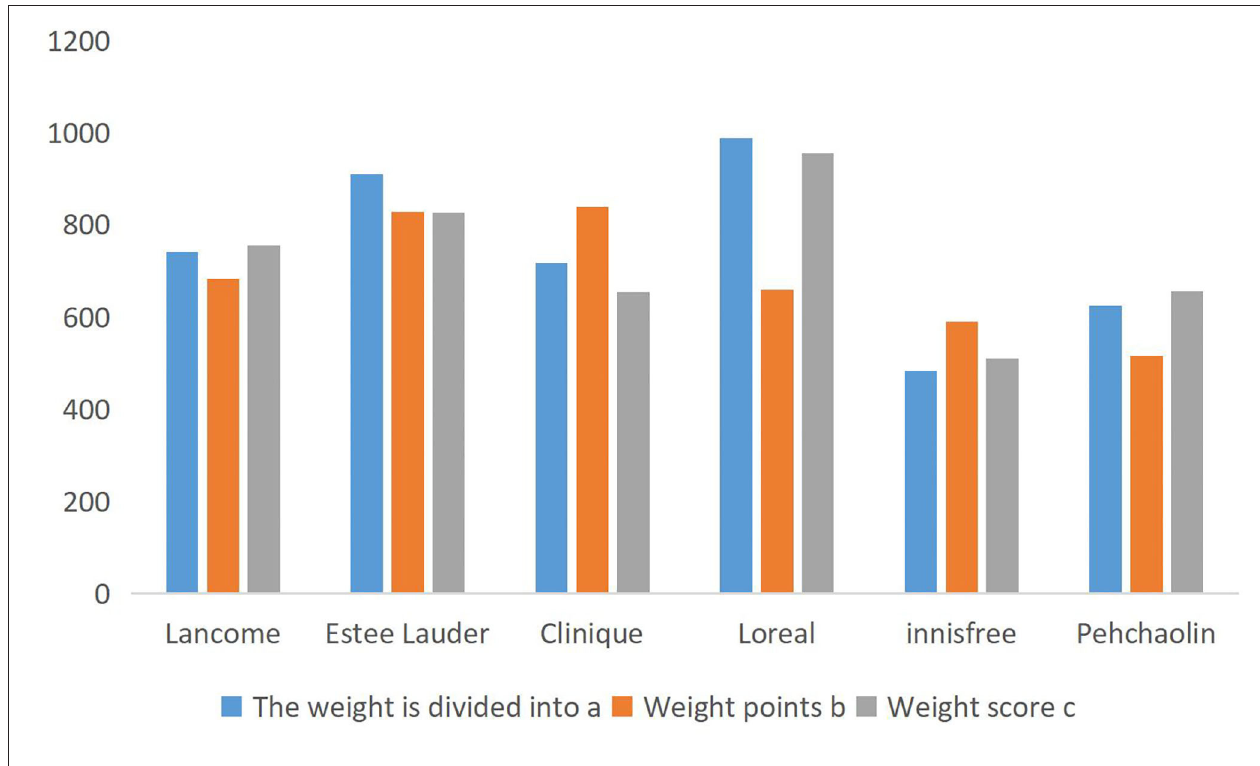
FIGURE 1 | Comparison of the data scores of different brands.